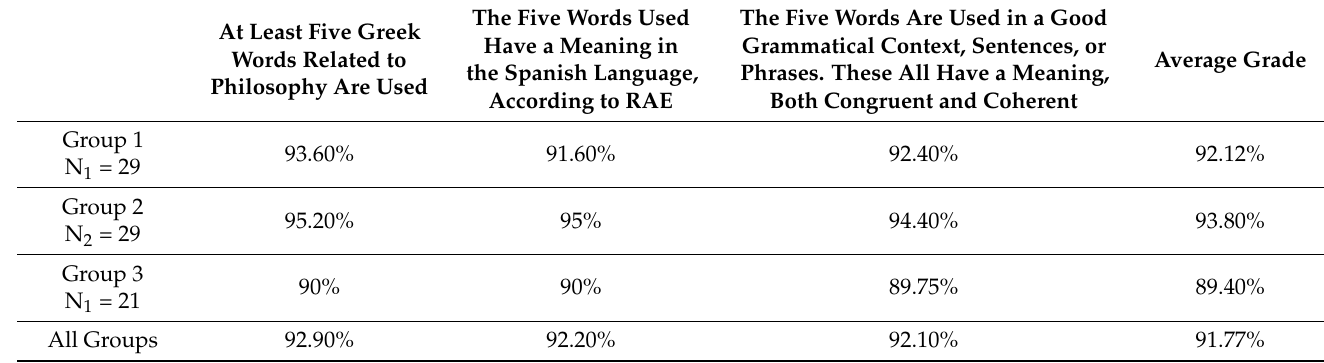
Table 3. Summative assessment’s results. The formative sequence described in Table 2 was replicated in three different